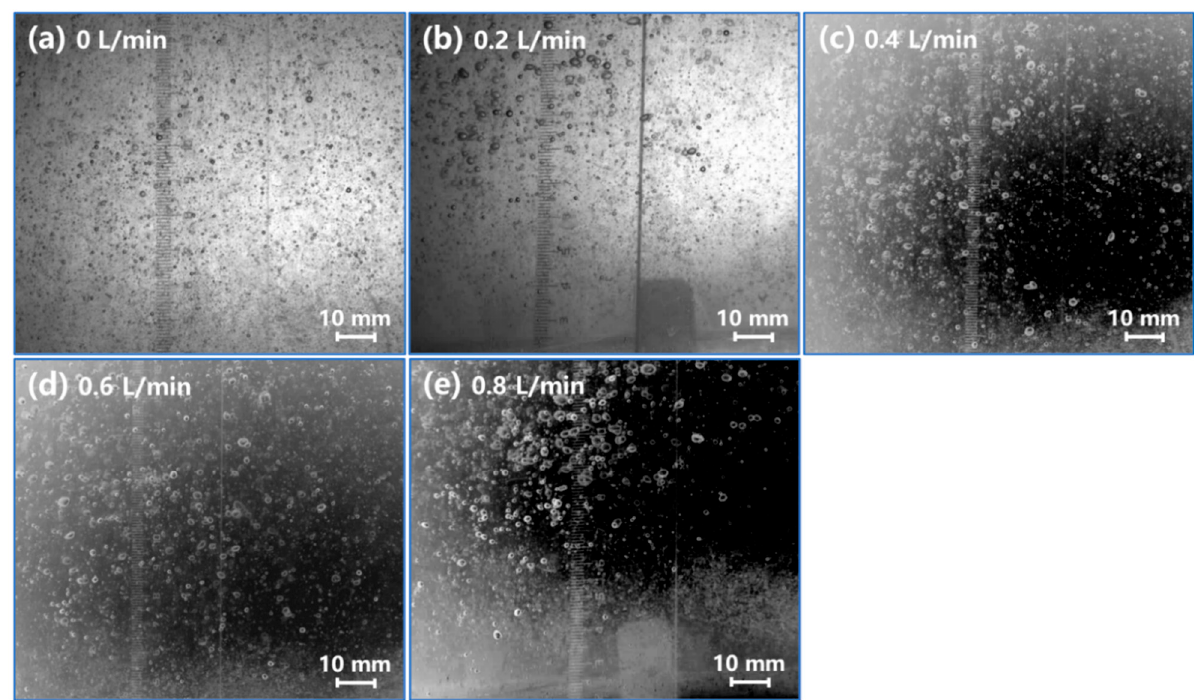
Figure 8. Images of the microbubbles and the corresponding size distribution at the flow rates of 0 L/min ( a ), 0.2 L/min ( b ), 0.4 L/min ( c ), 0.6 L/min ( d ), and 0.8 L/min ( e ).